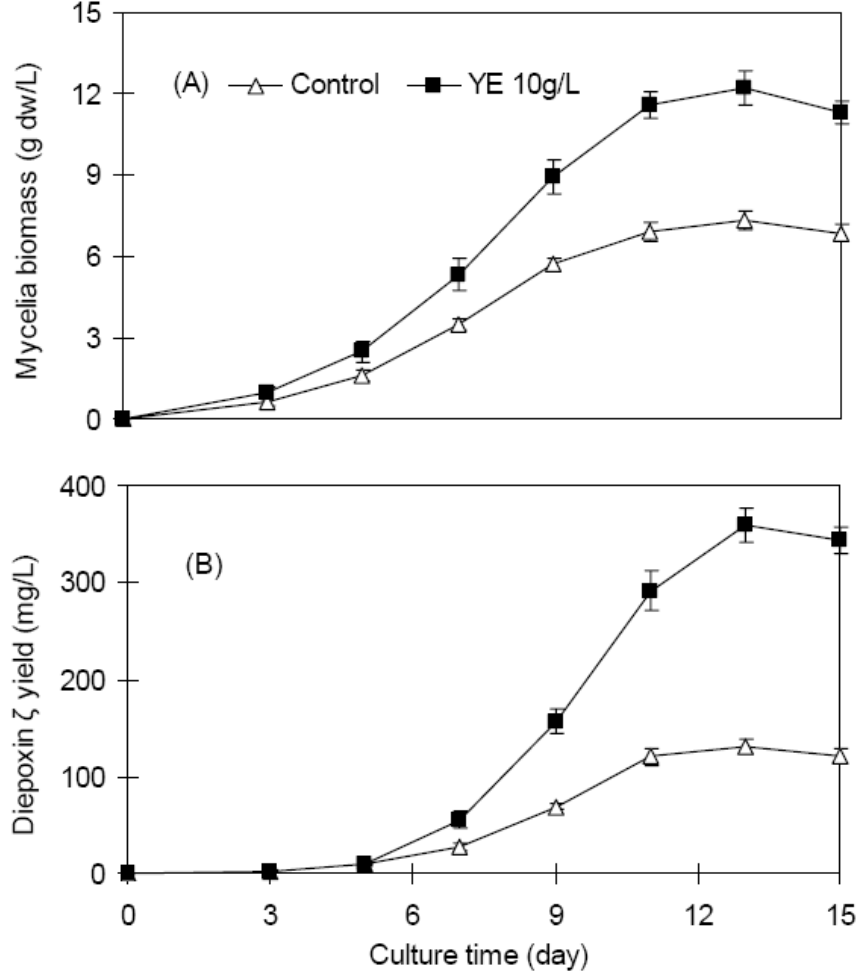
Figure 3. Kinetic studies of endophyte Dzf12 mycelia growth (A) and diepoxin ζ accumulation (B) after treatment with 10 g/L of YE. YE was added to the liquid medium on day 3, and the period of culture was 15 days; The error bars represented standard deviations, n =